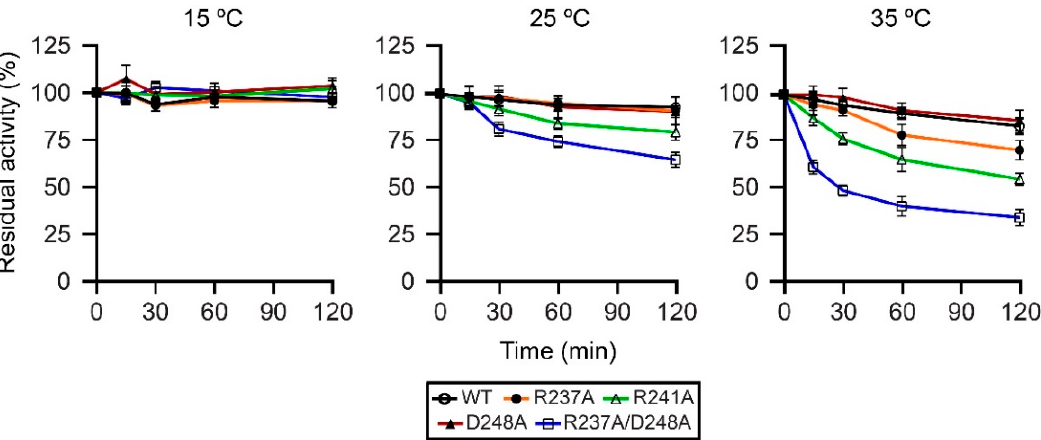
Figure 5. Thermal stability of WT and mutant PML enzymes. Data presented correspond to the mean ± SD of three experiments.